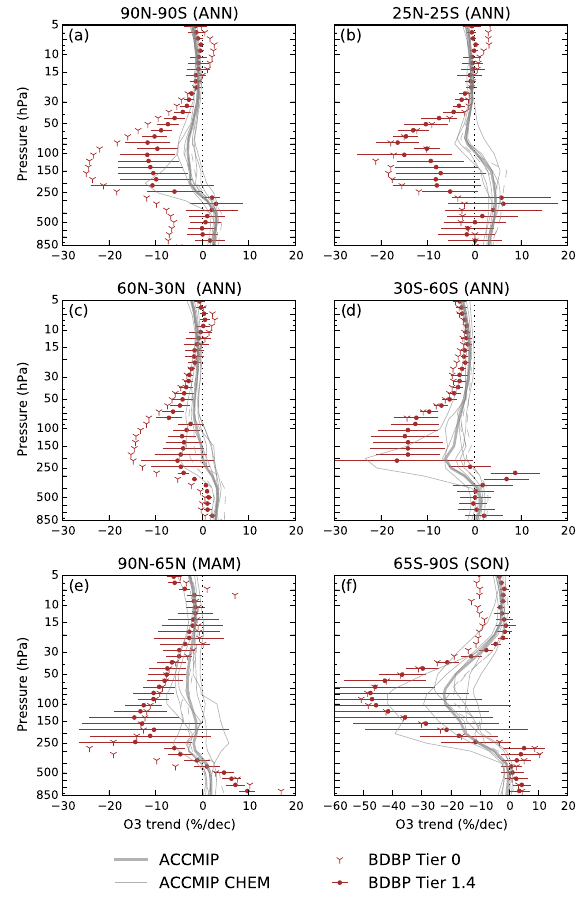
Figure 2. Vertically resolved ozone trends (%dec − 1 ) , for ACCMIP multi-model mean, CHEM and NOCHEM models compared to BDBP Tier 1.4 (regression model fit with uncertainty estimates indi- cating 95% confidence intervals, one tail) and Tier 0